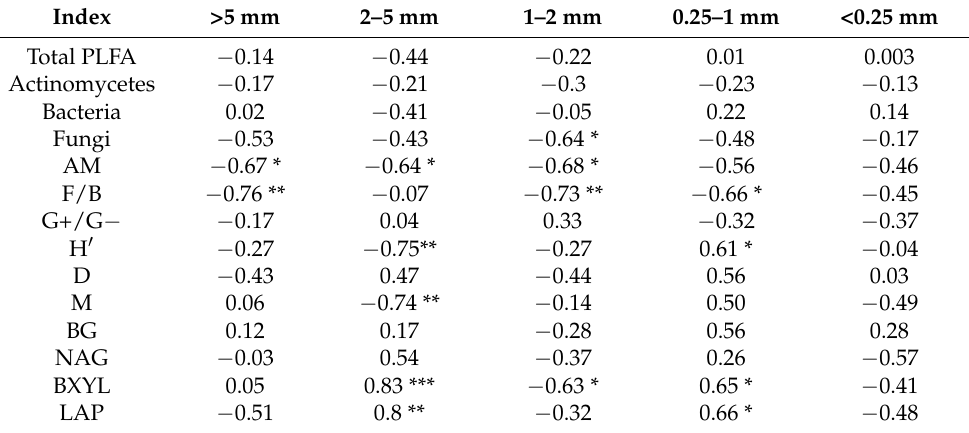
Table 4. Correlative coefficients between SOC and soil biological properties for CK, NP, NPS, and NPM in differently sized aggregates.